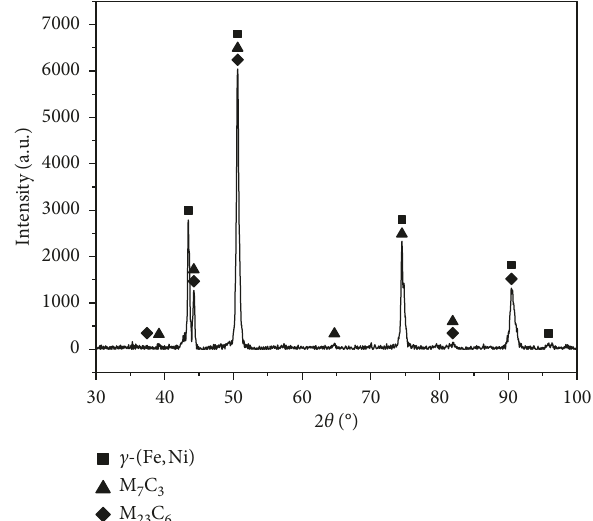
Figure 8: XRD pattern of NiCoCrAlY alloy